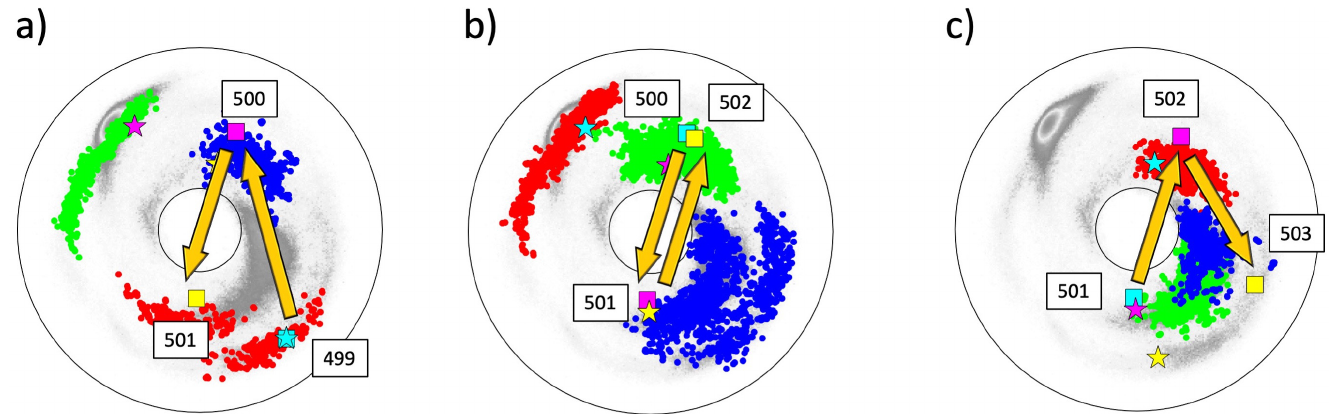
Fig 13. A hypothetical trajectory that rotates the direction of the C β atom at site 501 so that it turns and points to the opposite direction. The starred vertices are the same as in Fig 10, the vertices denoted by squares correspond to the hypothetical trajectory; the labeling a), b), c) is in direct correspondence with Fig 10.